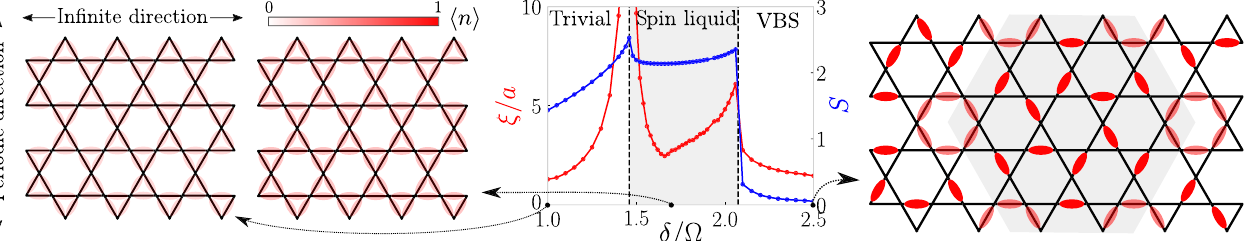
FIG. 2. Phase diagram of Rydberg blockade model on the links of the kagome lattice. The trivial phase at small δ = Ω is separated from the valence bond solid (VBS) at large δ = Ω by an intermediate phase which has a large entanglement plateau. We show an exemplary density plot for each of the three phases, which shows that the intermediate phase is featureless. The VBS phase has a 36-site unit cell (72 atoms on the links) highlighted by the gray shaded region — this pattern is studied in Refs. [82,83,113] in the context of the spin- 1 = 2 Heisenberg model on the kagome lattice. Numerical results are for a cylinder with XC-8 geometry, as depicted.